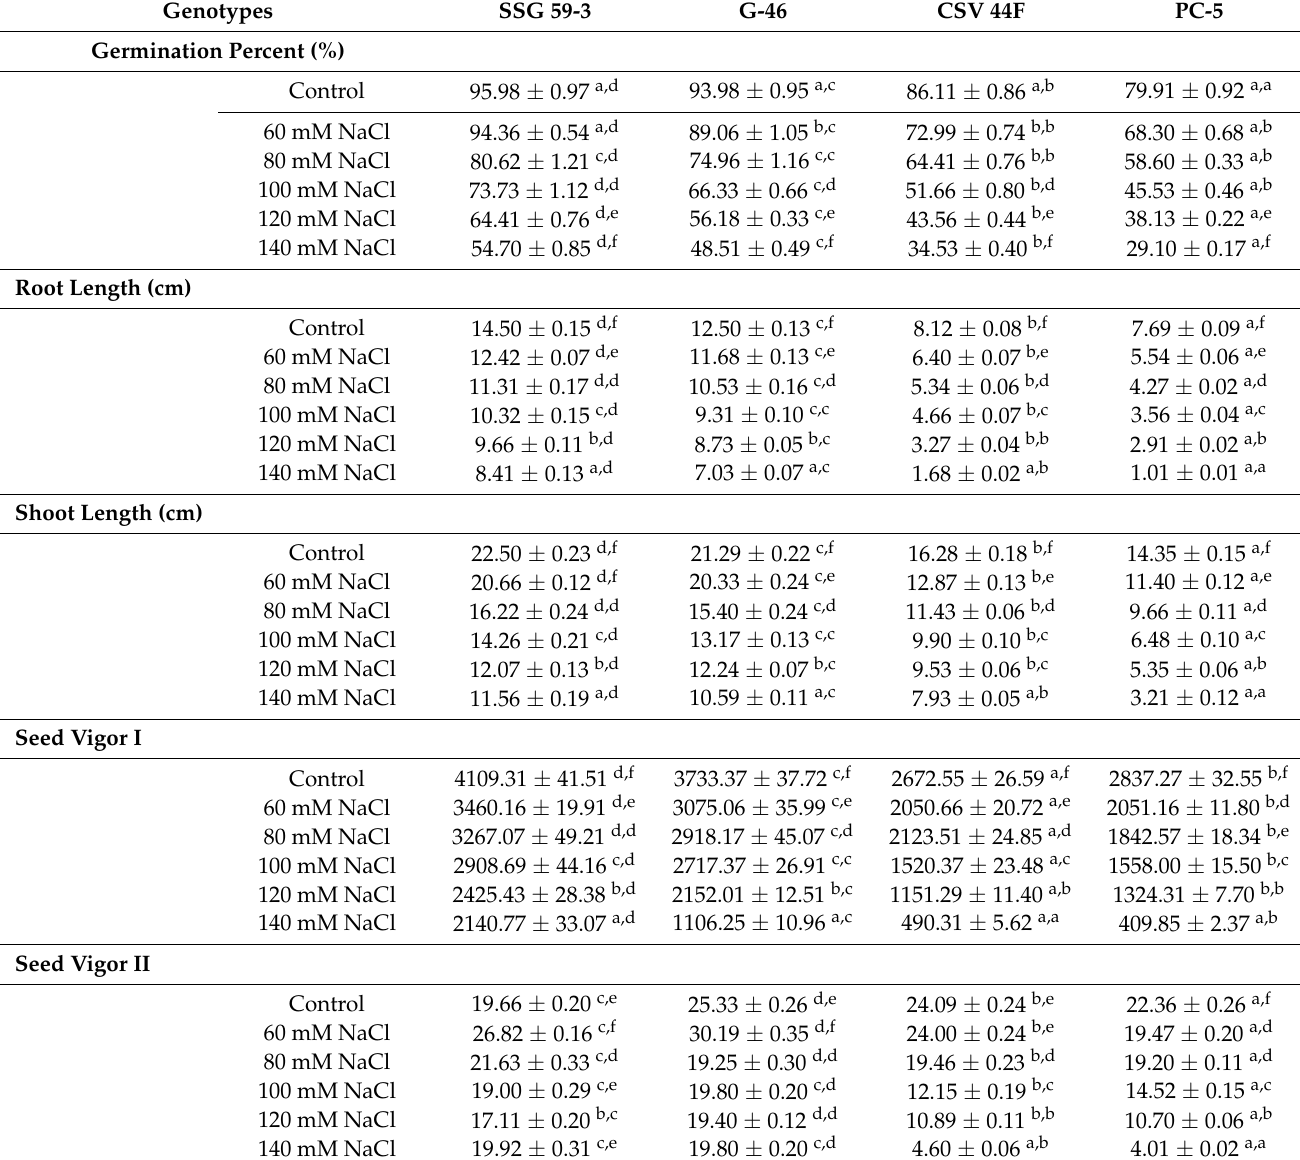
Table 3. Effect of salinity on germination indices of sorghum seedlings during the early growth